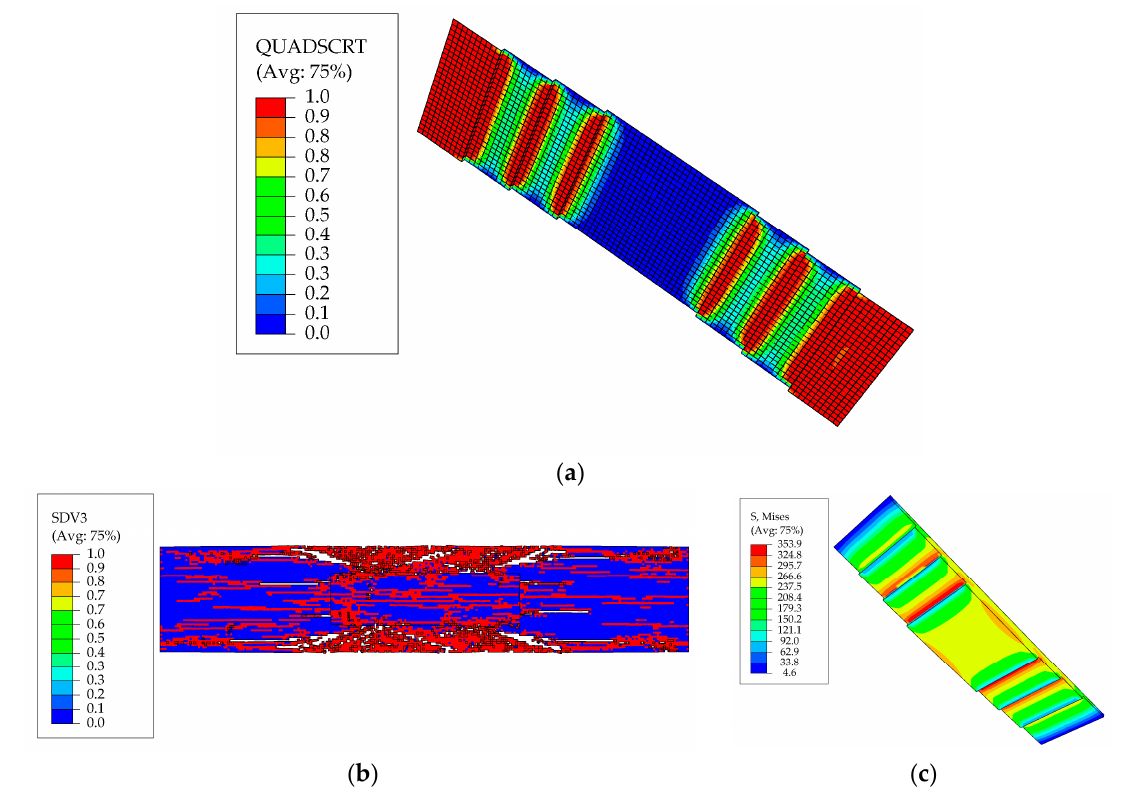
Figure 9. Failure mode of structural repair model: ( a ) failure factor nephogram of stepped-lap joint surface; ( b ) failure factor nephogram of parent structure; ( c ) stress nephogram of patch.